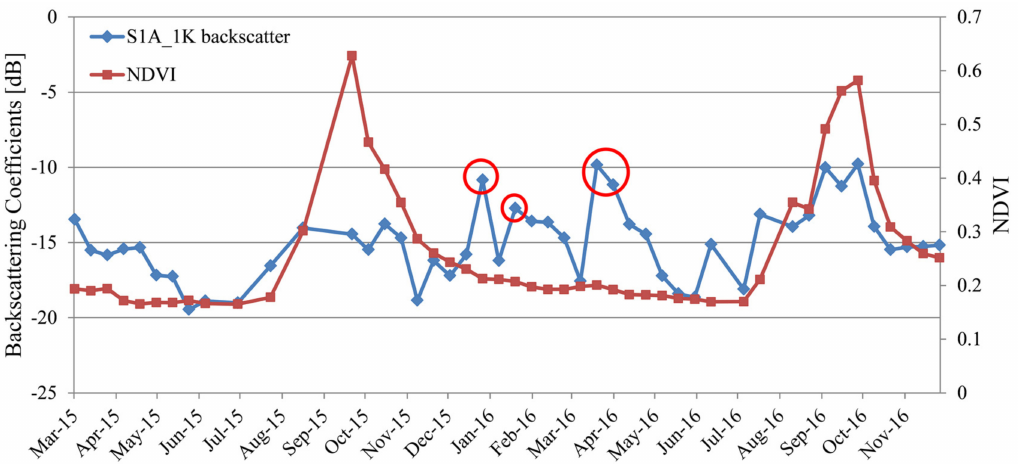
Figure 8. The backscattering coefficients of S1A and the NDVI at the Dahra study site. The red circles correspond to overestimations of